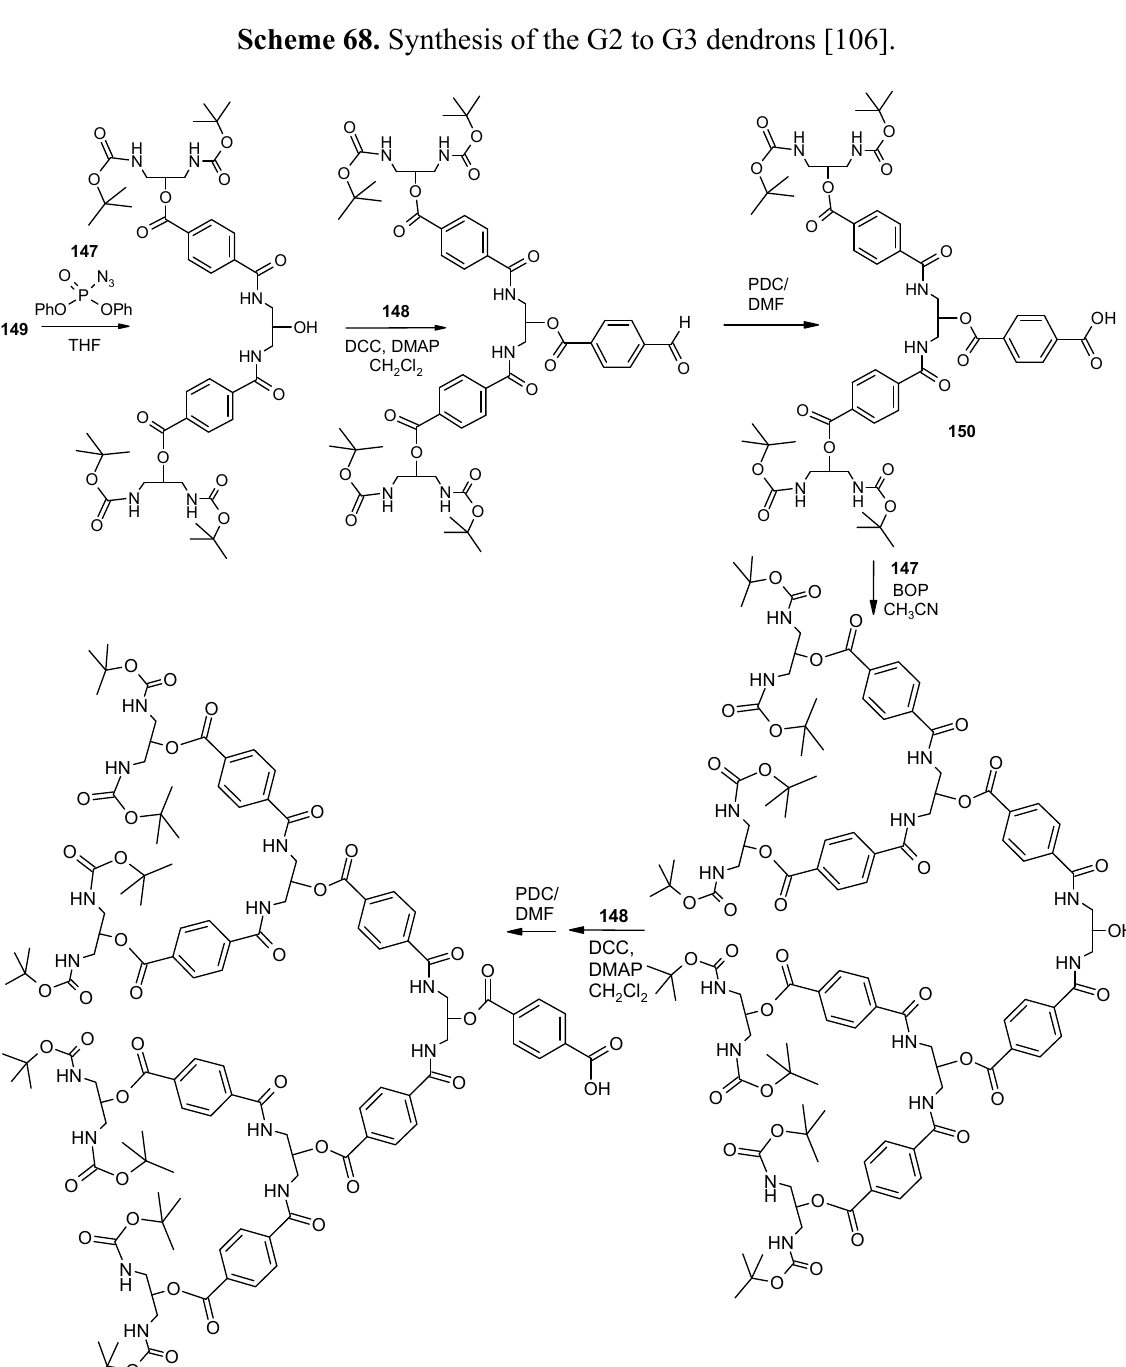
Scheme 68. Synthesis of the G2 to G3 dendrons